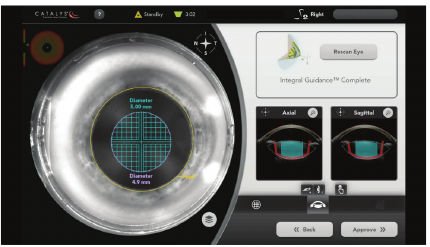
Figure 3: The Catalys femtosecond laser interface.